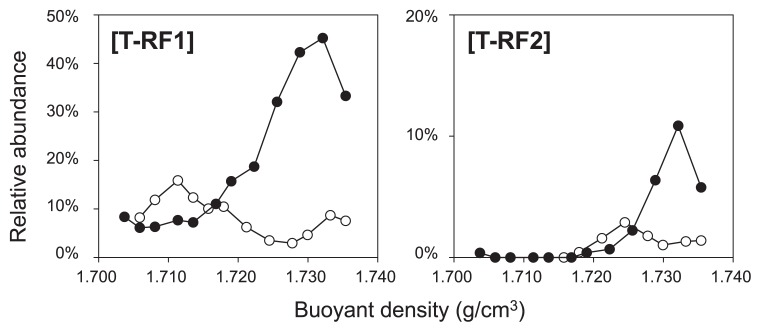
Relative abundance of T-RF1 and T-RF2 in each fraction of the ●: labeled treatment, and ○: unlabeled treatment on day 64. The x-axis shows the buoyant density (g cm−3) of each fraction.